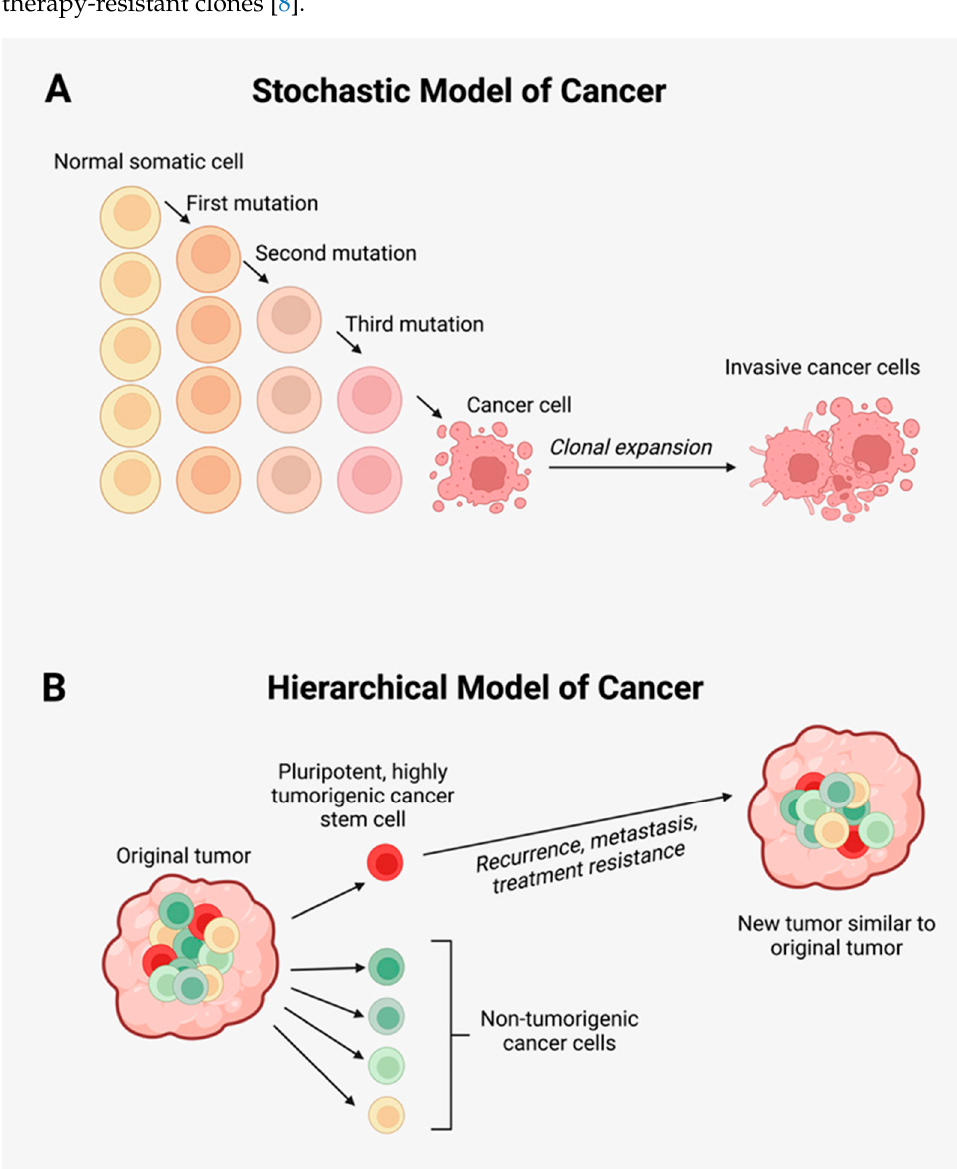
Figure 1. ( A ) The stochastic model of cancer proposes that a normal somatic cell accumulates oncogenic mutations in a stepwise manner and becomes a cancer cell that undergoes clonal expansion to form a tumor. ( B ) The hierarchical model of cancer proposes the presence of a highly tumorigenic cancer stem cell (CSC) sitting atop the tumor cellular hierarchy and divides asymmetrically to form non-tumorigenic cancer cells that form the bulk of the tumor, and identical CSCs that form new tumors like the original tumor. Adapted from the Atlas of Extreme Facial Cancer, Springer Nature [9]. Diagram recreated with BioRender.com, accessed on 1 November 2022. The hierarchical model of cancer, also known as the cancer stem cell (CSC) concept, proposes that tumorigenesis is driven by CSCs—a small subpopulation of quiescent